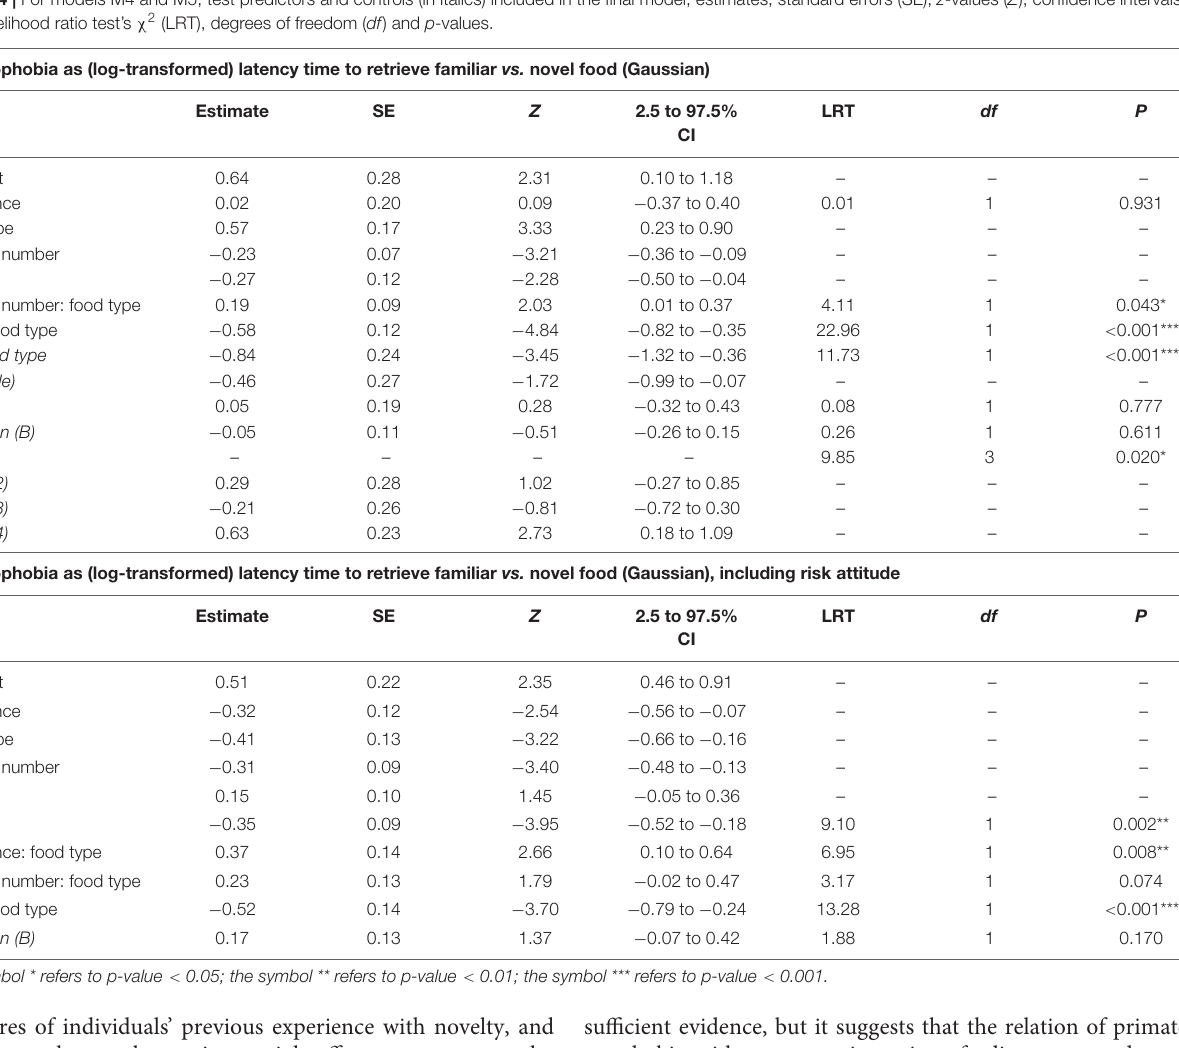
TABLE 4 | For models M4 and M5, test predictors and controls (in italics) included in the final model, estimates, standard errors (SE), z -values ( Z ), confidence intervals (CIs), likelihood ratio test’s χ 2 (LRT), degrees of freedom ( df ) and p